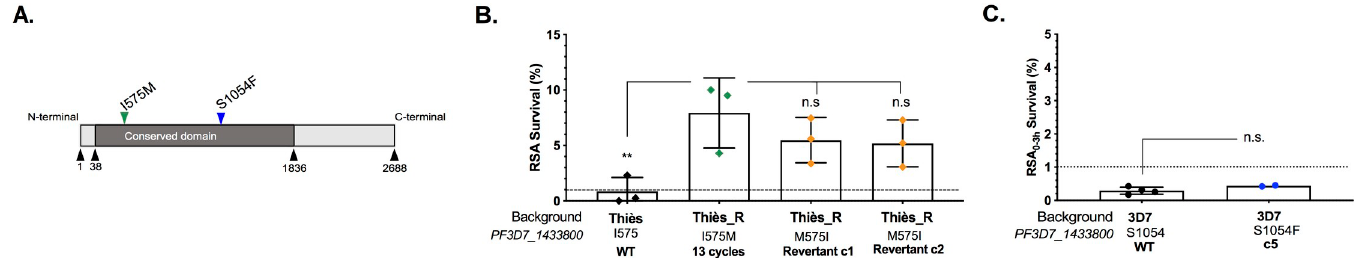
Fig 3. PF3D7_1433800 makes a minimal contribution to artemisinin resistance. A. Map of the conserved Plasmodium protein of unknown function (PF3D7_1433800) with the positions for mutations identified in Thi è s_R (I575M) and Pikine_R (S1054F) in its conserved domain [16]. B. Ring-stage survival assay (RSA) survival percentage for two clones of revertants (M575I, c1 and c2, orange) of PF3D7_1433800 mutation I575M in Thi è s_R compared to our previously published [17] survival for Thi è s_R (green) and wildtype (WT) Thi è s control (black). C. RSA survival percentage is shown for one clone of PF3D7_1433800 S1054F mutant in the 3D7 background (c5, blue), compared to the WT 3D7 control (black). Each data point represents an independent biological replicate and dotted line represents the 1% survival threshold, above which survival is considered resistant. Significance level is indicated by the asterisks, �� p < 0.01, determined using an unpaired two-tailed student t-test with Welch’s